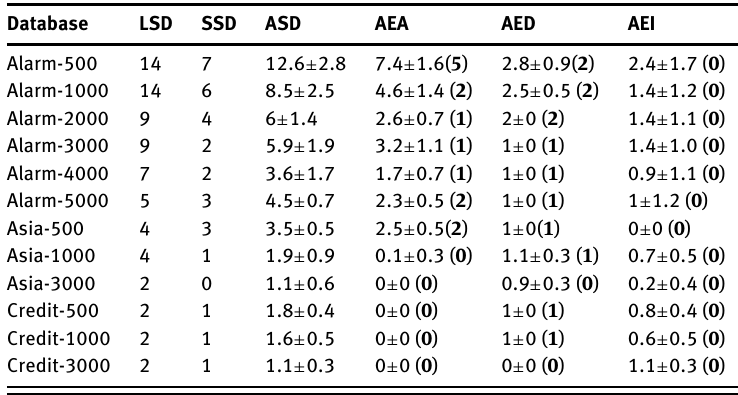
Table 3. The structural difference of BVD-MPSO-BN on different